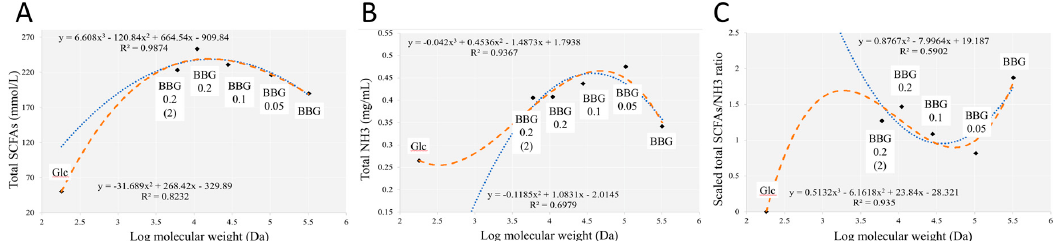
Figure 11. Correlation analysis of selected parameters against BBGs of different MWs with glucose as monomer. ( A ) Total short chain fatty acids (SCFAs); ( B ) total dissolved ammonia (NH 3 ); ( C ) SCFAs/NH 3 ratio after data scaling to both using the min-max approach.